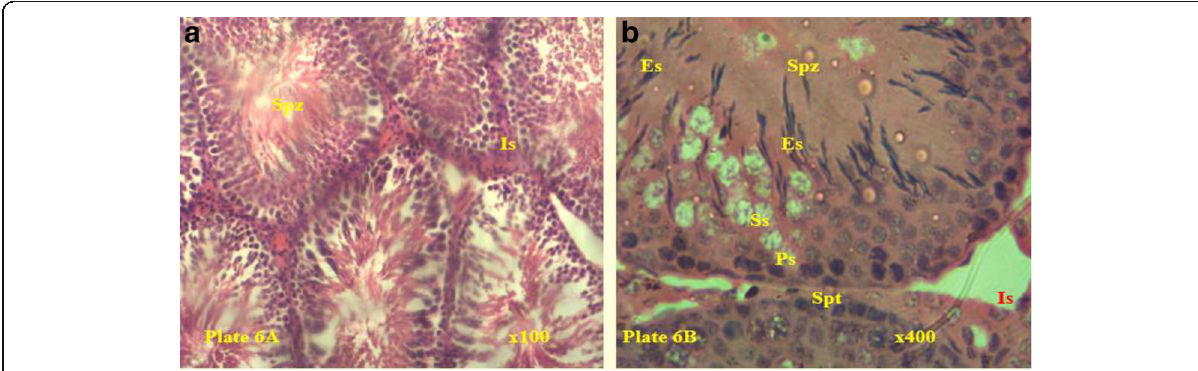
Fig. 10 a , b Photomicrograph of testes of group 4: Representative testicular micrograph of wistar rats given 100mg/kg/d of aluminum chloride and 2.5ml of pineapple juice (PJ) showing the structure of normal seminiferous tubules. Lc Leydig cell, Spt spermatogonia, Sp Secondary spermatocytes, Ps Primary spermatocytes, ES elongated spermatids, Spz spermatozoa. Stain is H&E and Magnification x 100 and x